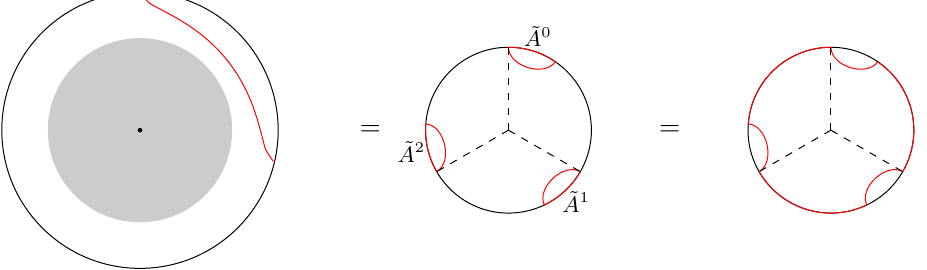
Figure 2 . The entanglement entropy of a subregion A in the conical defect is given by the entan- glement entropy of the union of all copies of A in the covering space or equivalently its complement. For a small interval, the RT surface is the union of the RT surfaces of the copies of A , while for a large interval it is the union of the RT surfaces of the complement. This exchange of dominance is the reason for the emergence of the entanglement shadow, depicted in grey on the